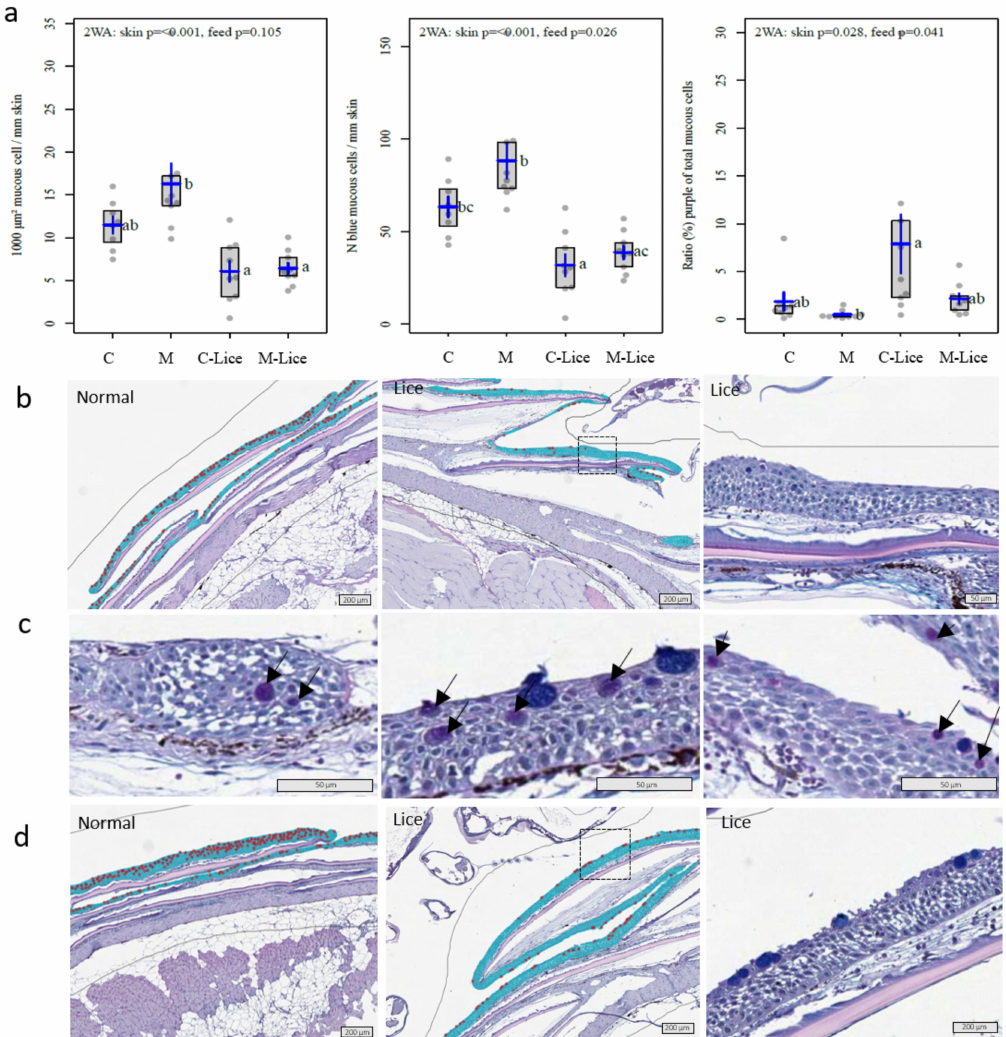
Figure 2. Mucous cell parameters and histology ( a ) Mucous cell area, mucous cell number per mm of skin, and the ratio of purple to total (blue + purple) mucous cell count. Two-way ANOVA followed with Tukey post hoc test, p -values for feed (normal skin control diet, versus normal skin mineral diet (M)) and skin (normal skin vs. lice affected skin) are shown on top of the plots. Boxes, which do not share a letter are significantly different ( p < 0.05). ( b ) AB/PAS stained tissue sections of fish skin fed the control diet. First column normal skin, second column skin with lice, third column enlargement of the dotted area in the second column. ( c ) Purple mucous cells (arrow) on skin tissue sections with lice fed the control diet. ( d ) Similar to b for the mineral diet. Artificial color overlay as presented by the AI-model, blue epidermis, red circles represent mucous cells counted as objects. Tissue sections without the artificial color overlay are presented for the illustration of mucous cell color (panel b), and epidermal morphology (vascularization and rough appearance of epithelial surface cells) typically observed at the feeding site (third column a and